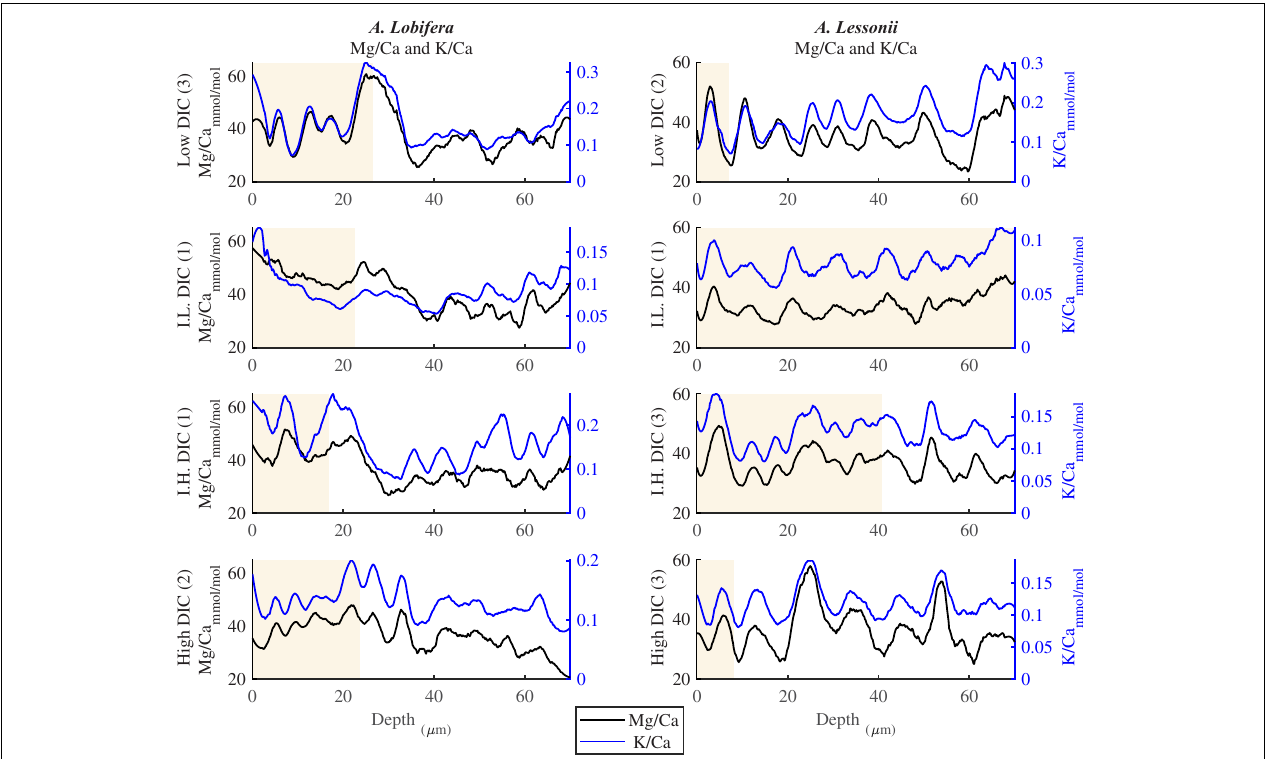
FIGURE 4 | K/Ca and Mg/Ca ratios in the knob profile of A. lessonii and A. lobifera for one selected specimen from each DIC treatment (data for all the specimens are given in the Supplementary Material ). Note that the K bands is following the Mg ones with high fidelity in both frequency and amplitude. These high Mg-K bands represent the dark layers shown in Fig 1b and are associated with the organic rich primary calcite while the thick low Mg-K bands represent the secondary calcite of the lamination process. The DIC treatment did not affect the elemental